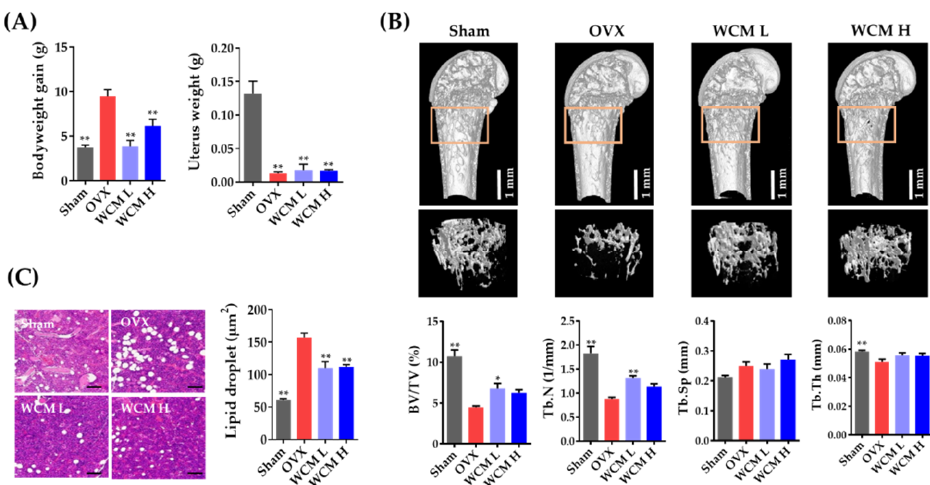
Figure 1. Water extract of Commiphora myrrha resin (WCM) alleviates estrogen deprivation-induced bone loss ( n = 5). ( A ) Alterations in body weight and relative uterus weight in the study groups. ( B ) Three-dimensional micro-CT images and morphometric parameters in micro-CT analysis of the femurs (scale bar, 1 mm). ( C ) Accumulation of lipid droplets in the bone marrow of distal femur detected by hematoxylin and eosin staining (scale bar, 100 µ m). Data are represented as mean ± SEM and analyzed by one-way analysis of variance with Dunnett’s post hoc test. * p < 0.05 versus OVX, ** p < 0.01 versus OVX. Sham, sham-operated/vehicle; OVX, OVX/vehicle; WCM L, OVX/WCM treatment (200 mg/kg/day); WCM H, OVX/WCM treatment (500 mg/kg). BV/TV, bone volume per tissue volume; OVX, ovariectomized mice; H, high-dose; L, low-dose; Tb.N, trabecular number; Tb.Th, trabecular thickness; Tb.Sp, trabecular separation.